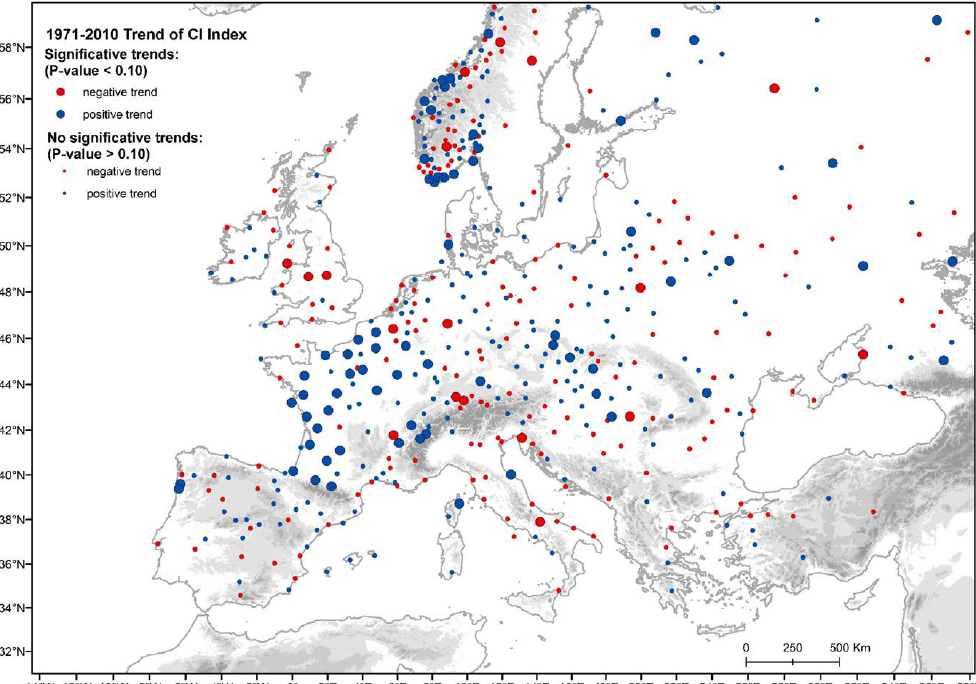
Fig. 11. Summer CI trend distribution (1971–2010). Positive trends are in blue and negative ones in red. Large dots represent significative trends ( p < 0 . 10), otherwise small dots are shown.